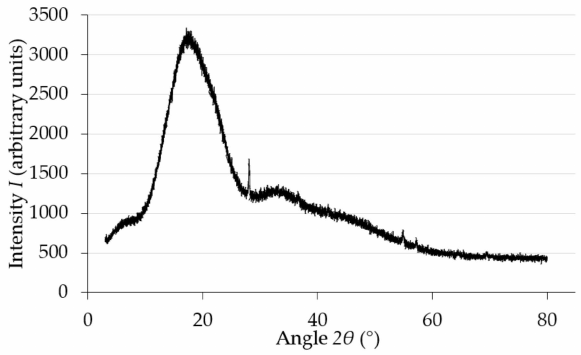
Figure 1. Diffractogram obtained for the tested PLA